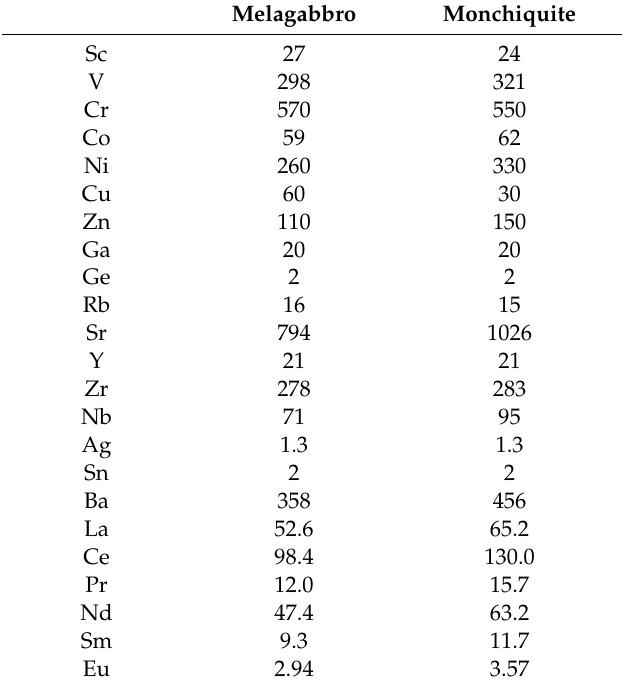
Table 2. Trace element contents of the melagabbro and monchiquite samples from San Giovanni in